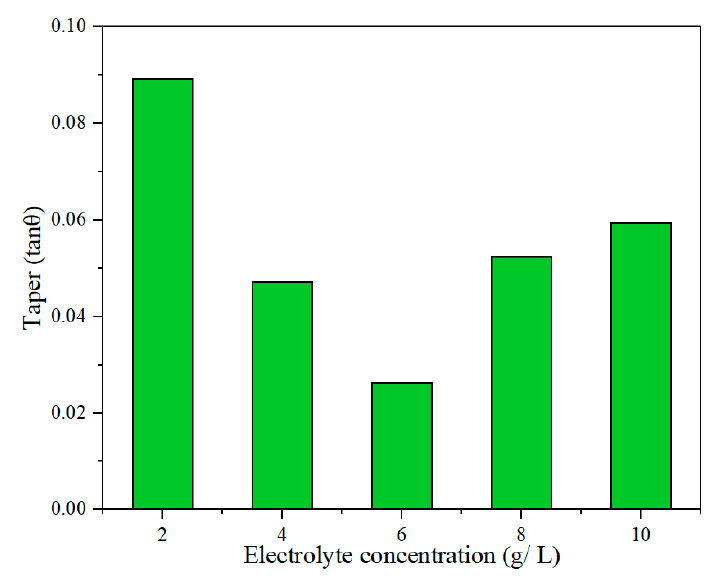
Figure 17. Effect of electrolyte concentration on hole taper in electrochemical reaming.